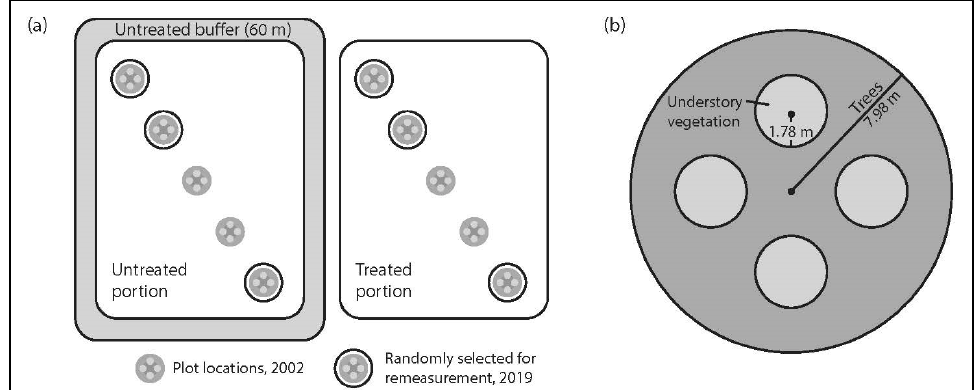
Figure 1. Plot design: ( a ) random selection of three plots from the five established in 2002; ( b ) subplot layout within each plot for non-tree vegetation, tree, sapling and tree regeneration data collection.